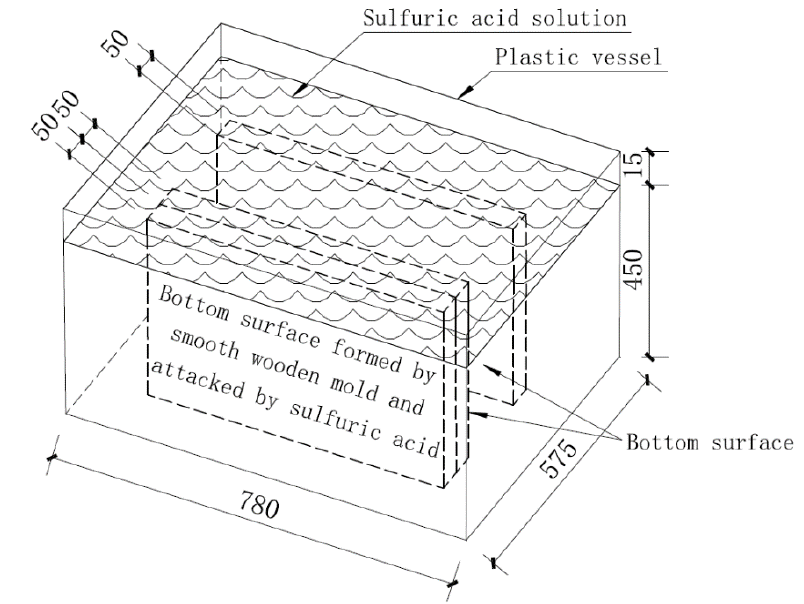
Figure 2. Three concrete plates arrangement in the plastic vessels (mm).